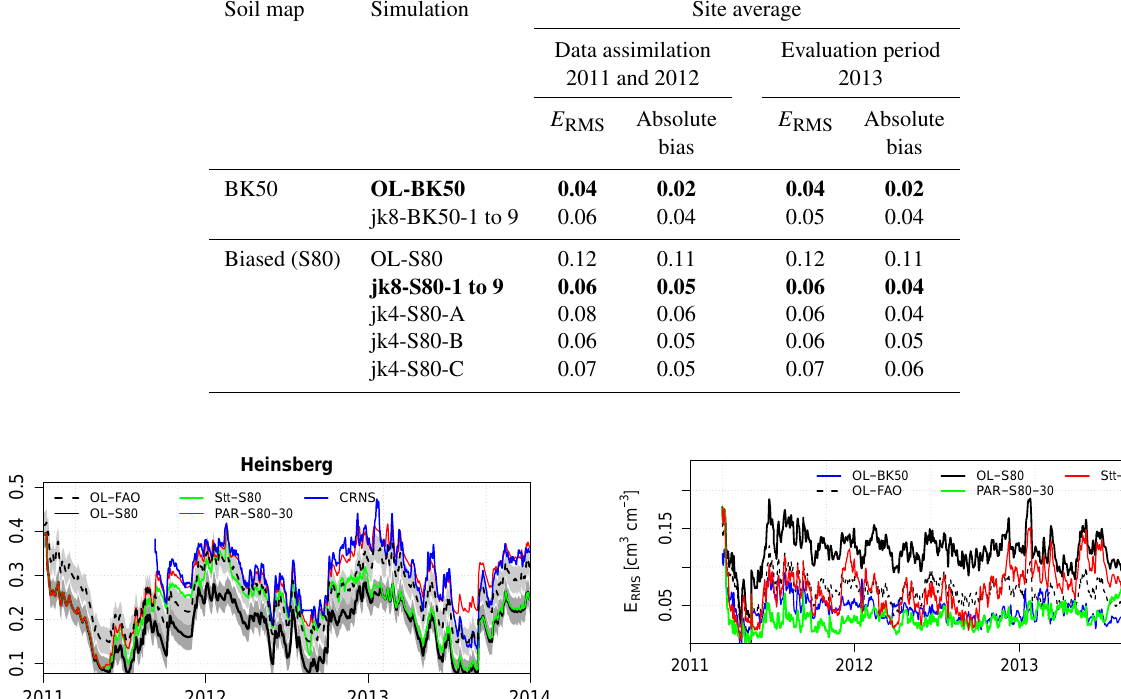
Figure 4. Temporal evolution of root mean square error ( E RMS ) for hourly SWC retrievals. E RMS is calculated hourly for all nine CRNSs for open loop (OL- ∗ ) runs for soil maps BK50, FAO and S80; joint state–parameter updates (PAR-S80-30); and state updates only (Stt-S80) during the assimilation period with joint state–parameter updates (2011 and 2012) and the verification pe- riod